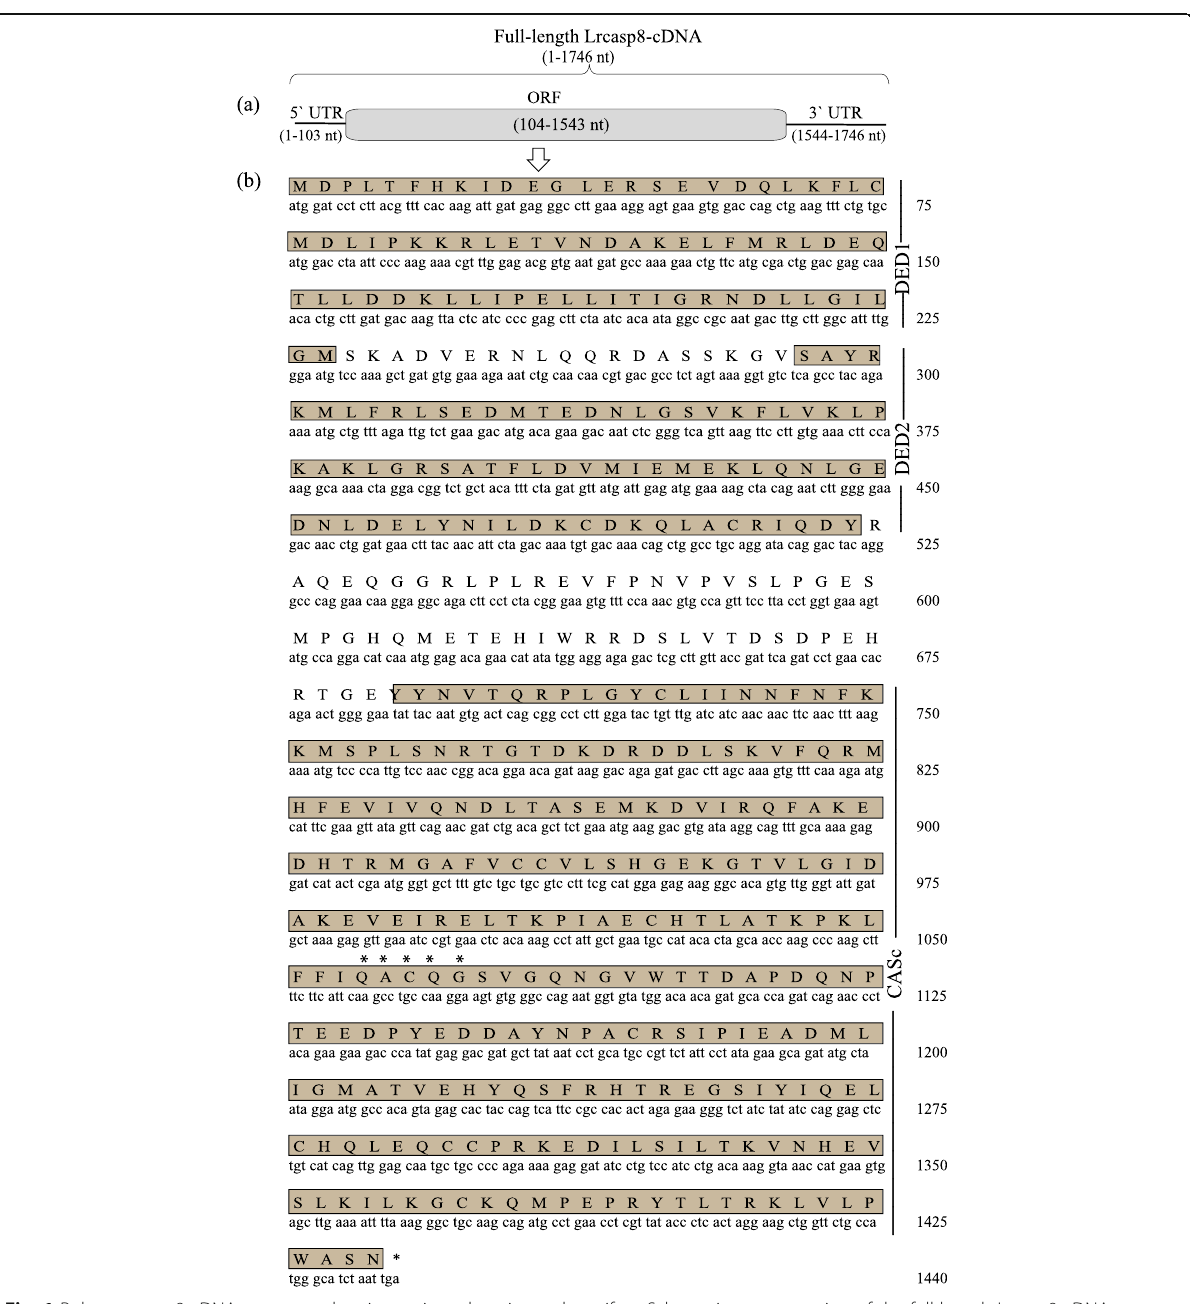
Fig. 1 Rohu caspase-8 cDNA sequence showing various domains and motifs. a Schematic representation of the full-length Lrcasp8 cDNA sequence showing ORF (open reading frame) and un-translated regions (UTR) at 5 ′ - and 3 ′ -ends. b Translated amino acids of the Lrcasp8 showing putative DED domains, CASc domain, and the penta-peptide motifs “ QACQG ” (marked with “ * ”